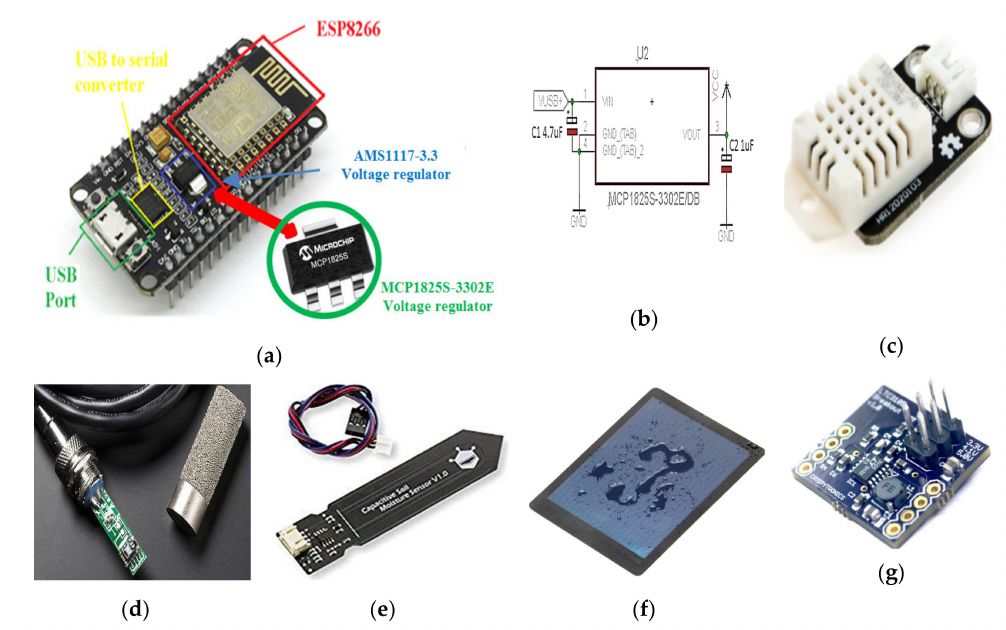
Figure 8. View of ESP8266 NodeMCU module with highlighted the main components included ( a ) AMS1117-3.3 voltage regulator replaced with the MCP1825S-3302E one; ( b ) schematic of MCP1825S-3302E voltage regulator used for reducing node power consumption; ( c ) DHT22 temperature and humidity digital sensor; ( d ) SEN0193 capacitive moisture sensor (DFRobot); ( e ) SHT11-based soil temperature and moisture digital probe (Sensirion); ( f ) 1.5-W amorphous silicon solar panel; ( g ) LTC3105 energy harvester breakout (by